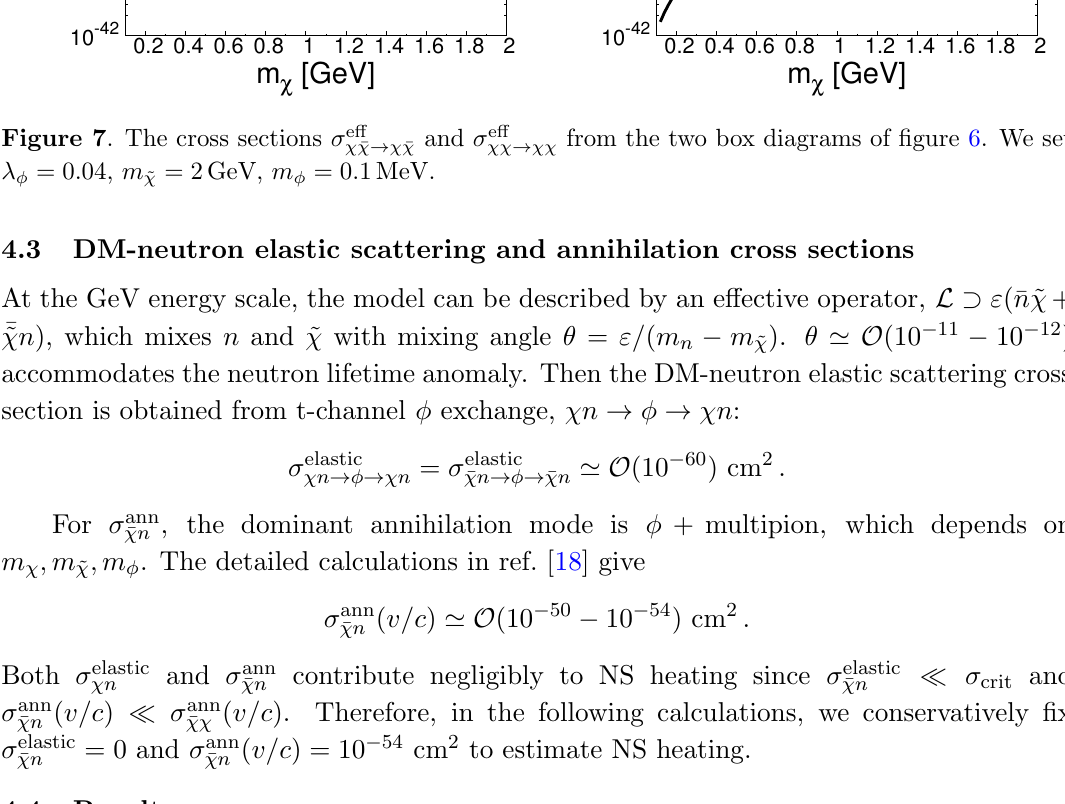
and (cid:27) e(cid:11) from the two box diagrams of (cid:12)gure 6. We set (cid:31) (cid:22) (cid:31) ! (cid:31) (cid:22) (cid:31) (cid:31)(cid:31) ! (cid:31)(cid:31)